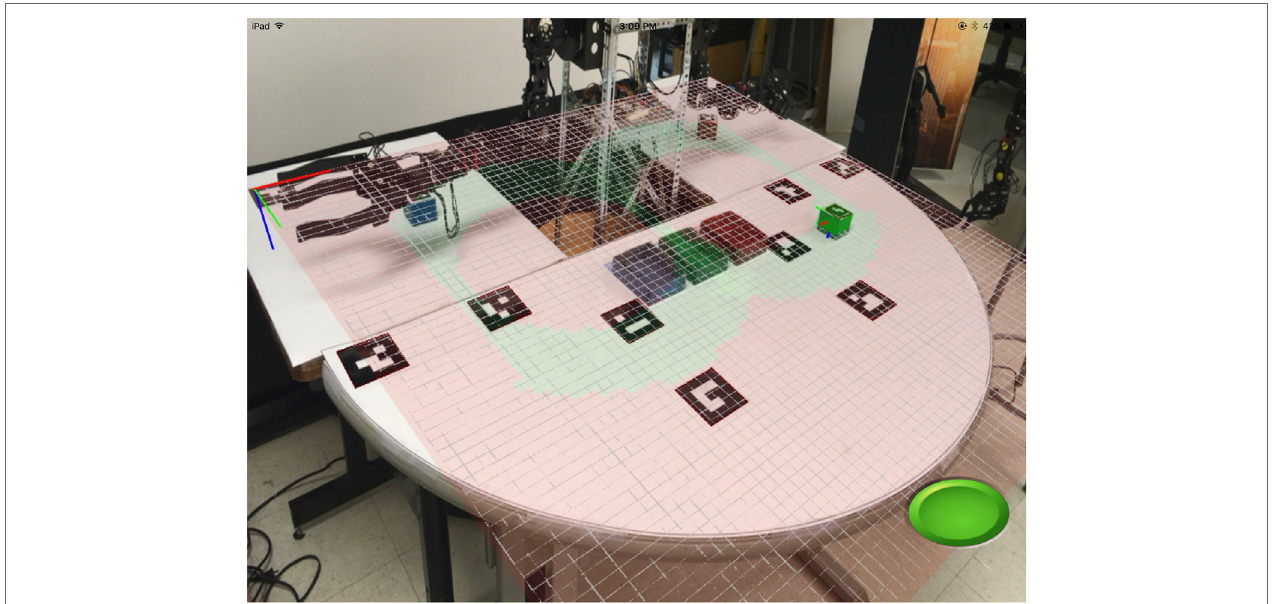
FigUre 3 | screenshot of the mixed-reality environment with the plot of the robot’s reachable space enabled .